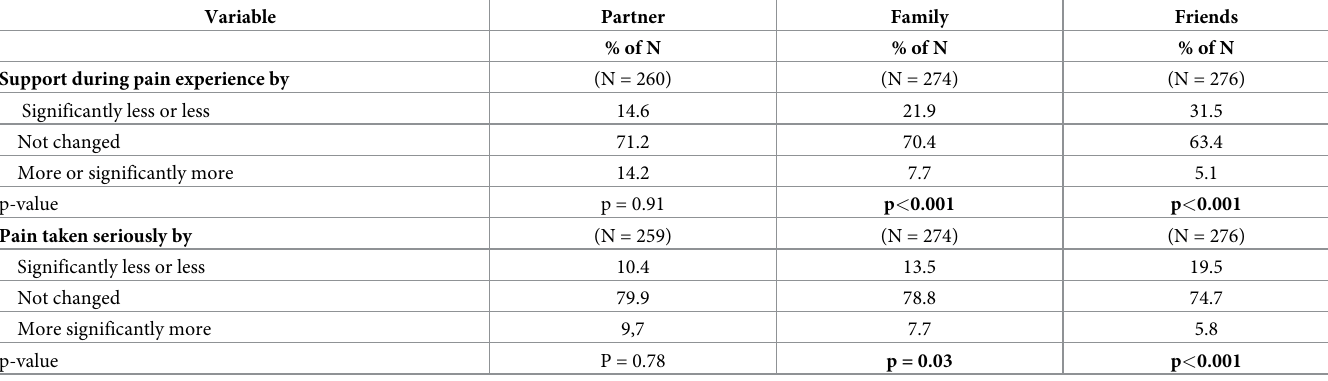
Table 7. Alterations in social support regarding pain experience during social